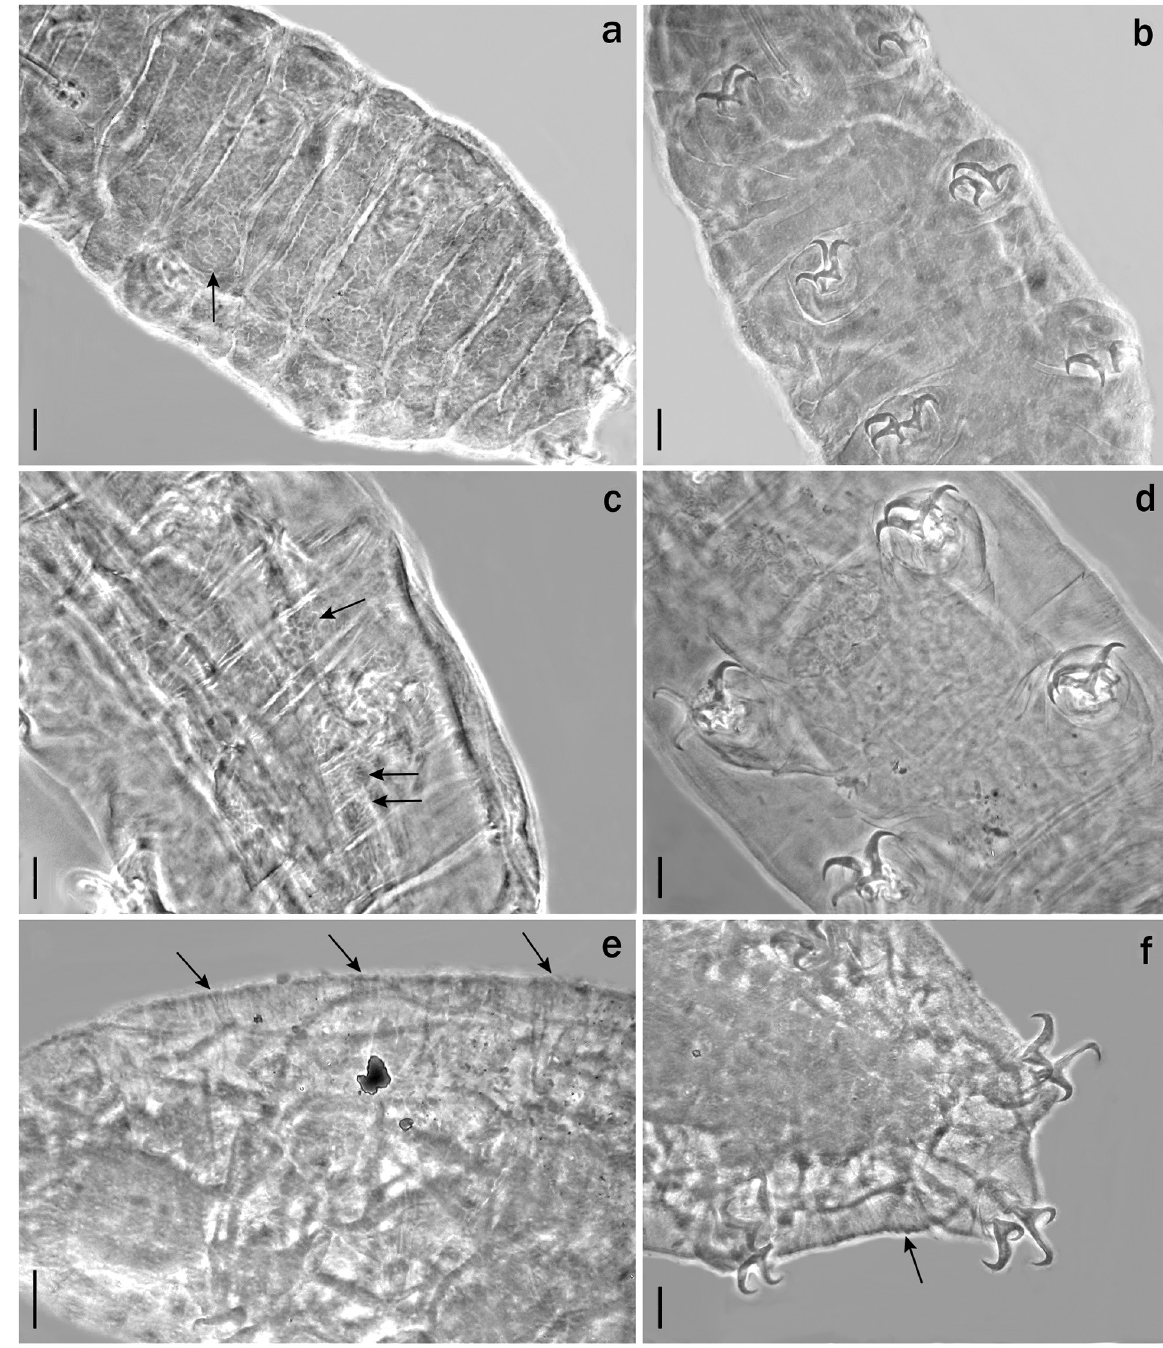
Figure 5. Holotypes of the species most similar to Mixibius gibbosus sp. nov. (a-b) Mixibius ornatus (slide No. 4770): (a) dorsal cuticle (the arrow indicates a weak gibbosity-like structure); (b) claws. (c-d) Mixibius sutirae (slide No. 4990): (c) dorsal cuticle (the arrows indicate some groups of tubercles); (d) claws. (e-f) Mixibius schnurae (slide No. 5420): (e) dorsal cuticle (the arrows indicate some bands of rugosity); (f) caudal end of the body showing claws of legs IV, and some tubercles (arrow). All material deposited in the Pilato and Binda collection (University of Catania). Scale bars are all 10